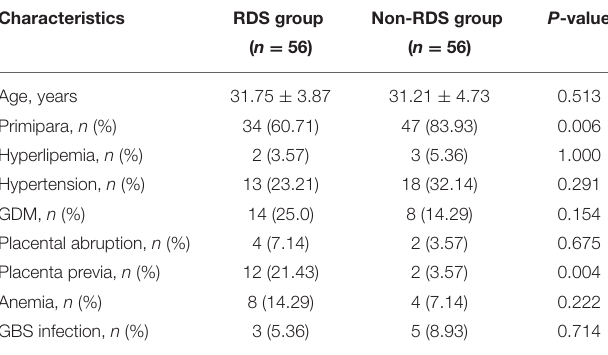
TABLE 2 | Baseline characteristics and pregnant complication of 112 pregnant women.